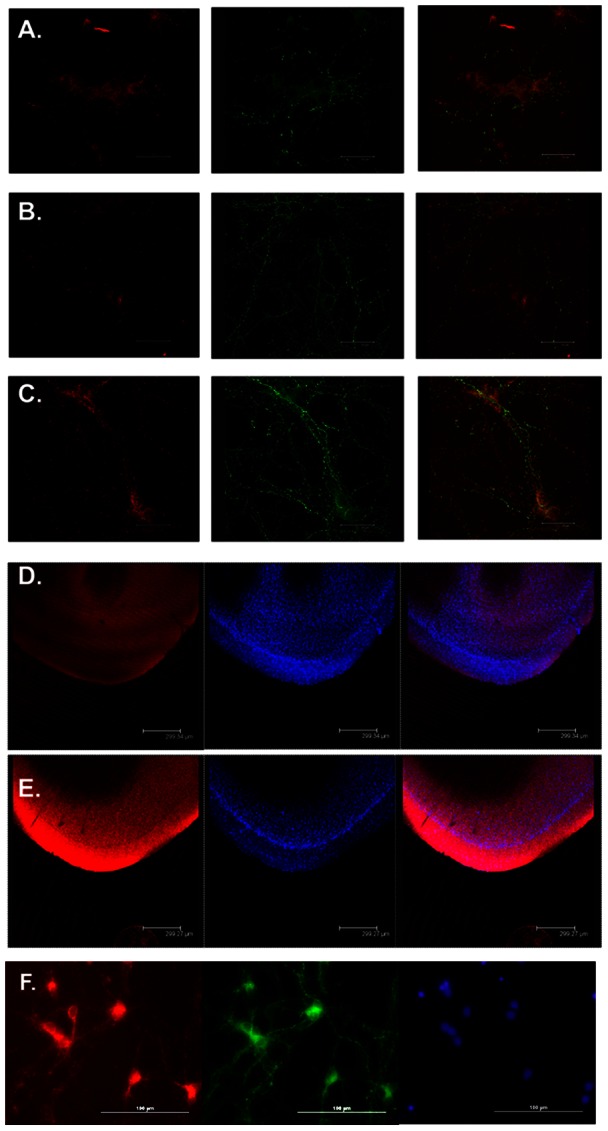
Mood stabilizer treatment resulted in increased mitochondrial transport to the synapse in cell culture as indicated by increased staining of neuronal processes and rat PFC tissue.From left to right: MitoTracker (red), SYN1 (green), and superimposed images (red and green). A. Saline control, B. Lithium (1 mM) treated cells, C. Paliperidone (10 µM) treated cells, D. Saline treated rat PFC tissue slice (left to right: MitoTracker red, DAPI nuclear stain and superimposed image), E. Lithium (22 mg/Kg) treated rat PFC tissue slice (left to right: MitoTracker red, DAPI and superimposed image). F. A close-up of localization of Mito Tracker red (red, left) and SYN1 (green) in paliperidone (0.1 µM) treated cells. Nuclei shown in blue (Secondary antibody: Alexafluor488 Mouse 1∶1000, Mitotracker CFX-Ros 50 nM, Hoecsht nuclear stain 1∶1000).